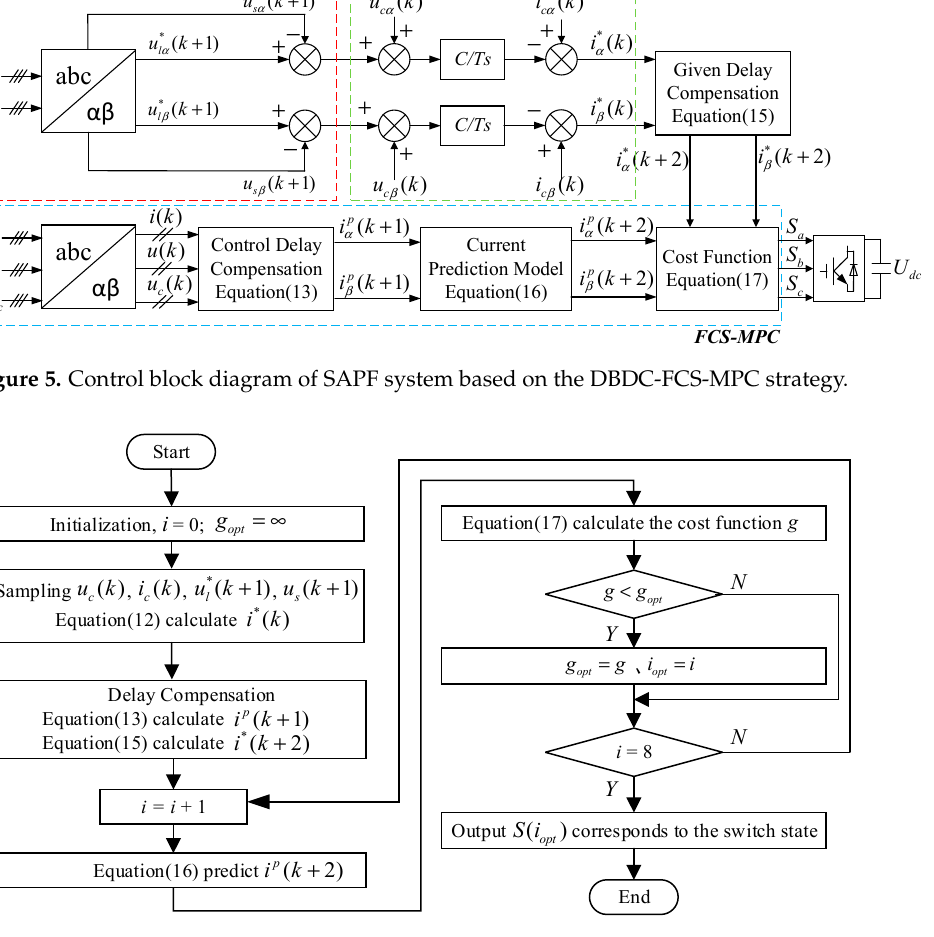
Figure 6. Flow of the DBDC-FCS-MPC strategy.